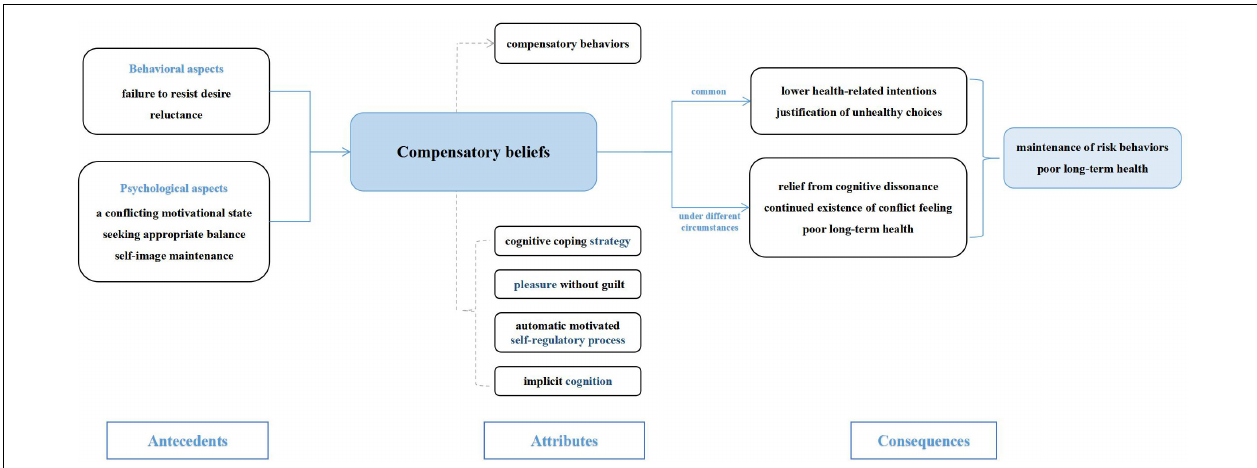
FIGURE 4 | Proposed conceptual model of